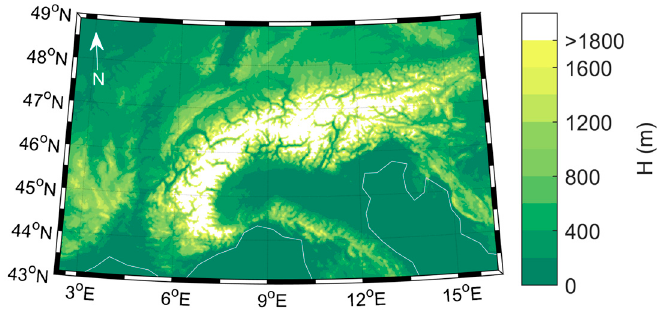
Figure 1. Consortium for Small-Scale Modelling (COSMO)-2 orography field for the studied area.